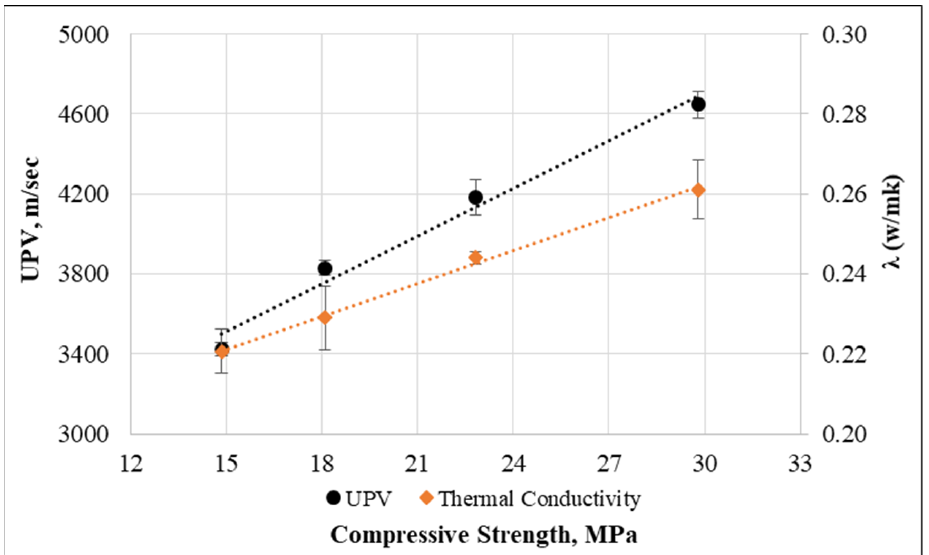
Figure 30. Relationship between UPV, thermal conductivity, and compressive strength.